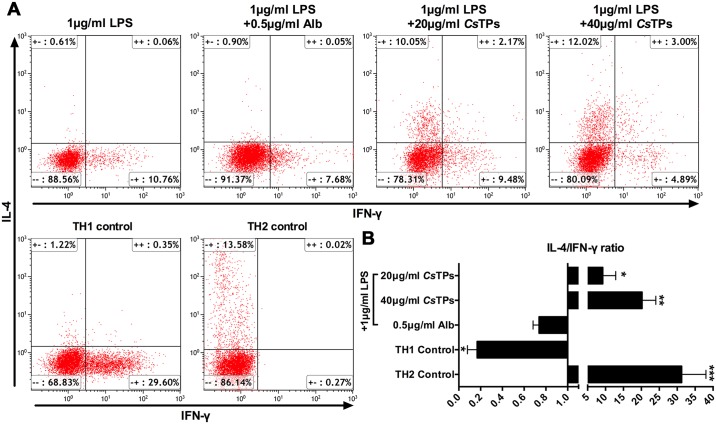
Effect of CsTPs-stimulated BMDCs on the regulation of Th2 polarization.(A) Representative images of IL-4 or IFN-γ positive CD4+ T cells after co-culturation with CsTPs-stimulated BMDCs in the presence of LPS analyzed by FACS. BMDCs were stimulated as described for 24 hours and 1×104 pre-treated BMDCs were co-cultured with 1×105 MACS-sorted CD4+ T cells for 10 d. T cells were intracellularly stained for IL-4 and IFN-γ after the stimulation of primed T cells with 1×Cell Stimulation Cocktail (plus protein transport inhibitors) for 5h, and then the stained cells were measured by FACS. (B) Statistical analysis of the ratio of IL-4 positive to IFN-γ positive CD4+ T cells. Three representative experiments were shown. Data are presented as mean ± SD and statistical significance was analyzed by one-sided paired Student’s t-test (*, P< 0.05; **, P < 0.01; ***, P < 0.001 vs. LPS group).